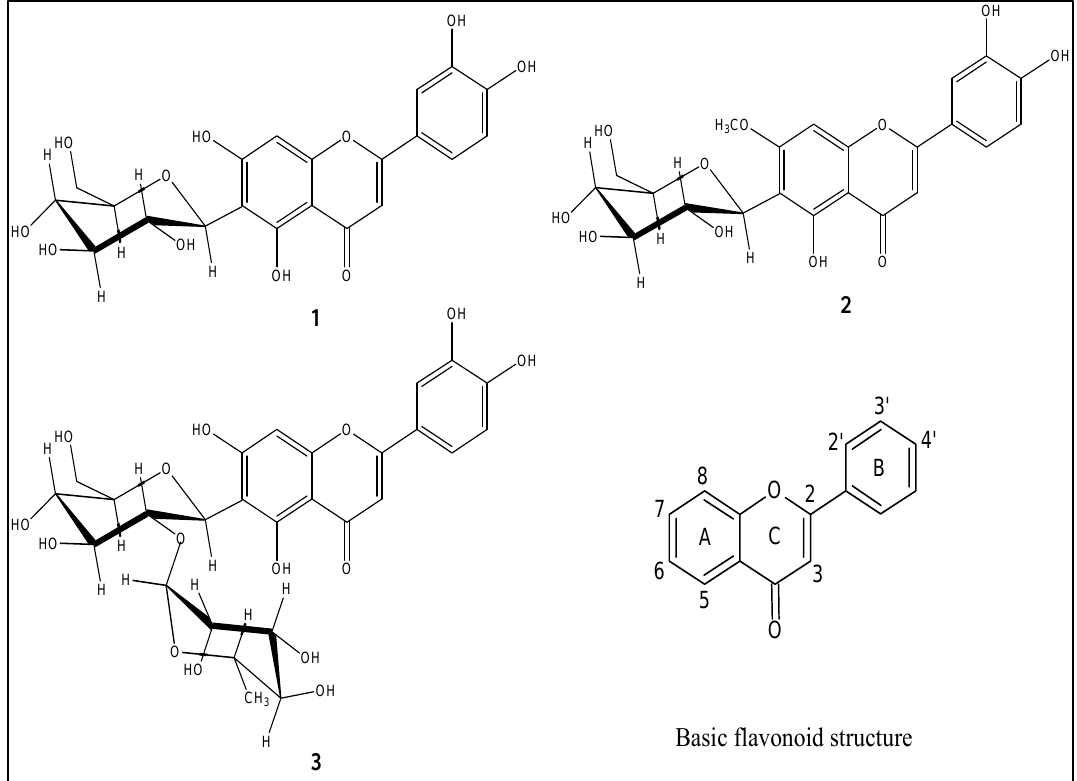
Figure 3. Chemical structures of isoorientin ( 1 ), swertiajaponin ( 2 ) and isoorientin 2"- O - rhamnoside ( 3